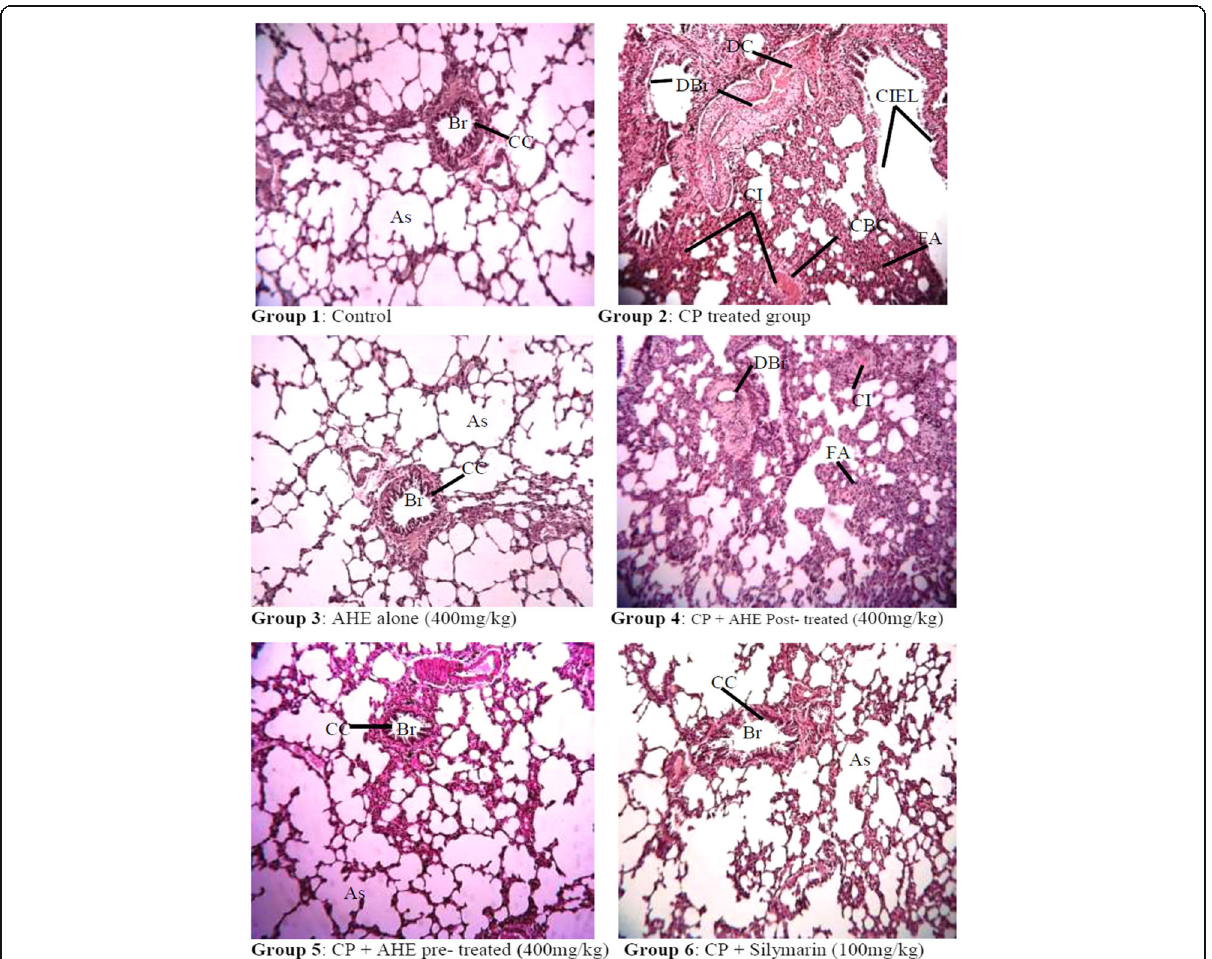
Fig. 2 Histopathological effect of cisplatin and protective effect of AHE in rat Lungs. (H&E staining; magnification 40X). Group 1: Lung tissue section from control rats showing normal morphology. Group 2: tissue sections from CP-treated rats show degenerative changes, atrophy and cellular infiltrations. Group 3: Represents lung section from AHE alone treated rats. Group 4: AHE Post-treatment showed mild disorganizations, cellular infiltrations and fibroblast aggregations. Group 5: AHE Pre-treatment showed significant protection against CP-induced lung injury. Group 6: Showed protective effect of Silymarin treatment. AHE- A. hydaspica ethyl acetate fraction, CP-Cisplatin, Br-Bronchioles, As-Alveolar septum, CC-Clara cells, T- Tubules, CI- Cellular infiltrations, DBr-Di- sorganized bronchioles, FA- fibroblast aggregations, CIEL-collapsed inner epithelial